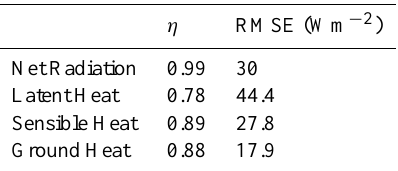
Table 2. Nash and Sutcliffe index and RMSE for the energy fluxes. η RMSE (Wm − 2 )